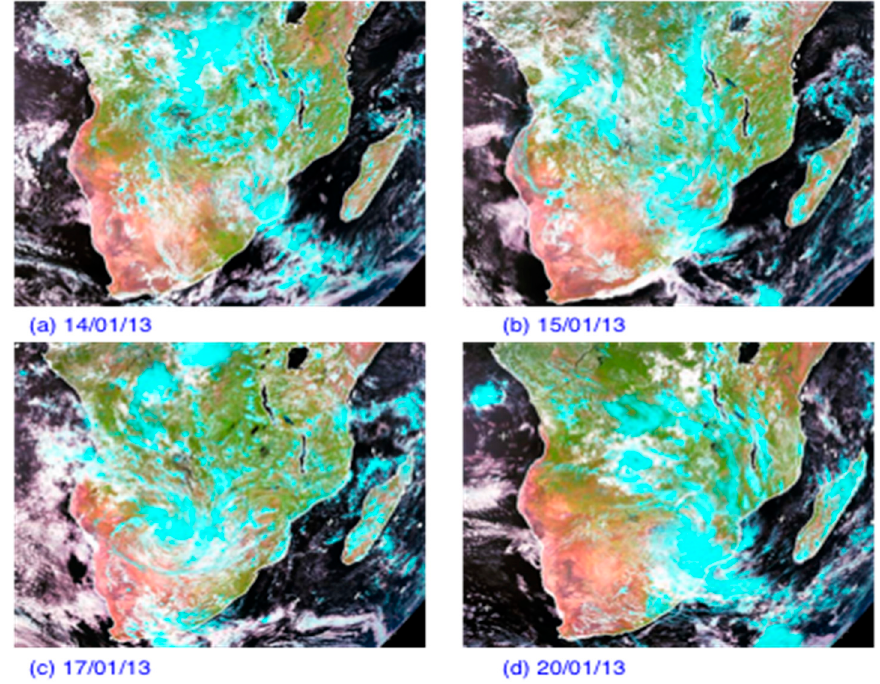
Figure 10. Cloud imagery over southern Africa on 14 ( a ), 15 ( b ), 17 ( c ) and 20 ( d ) in January 2013. (http://www.sat.dundee.ac.uk).